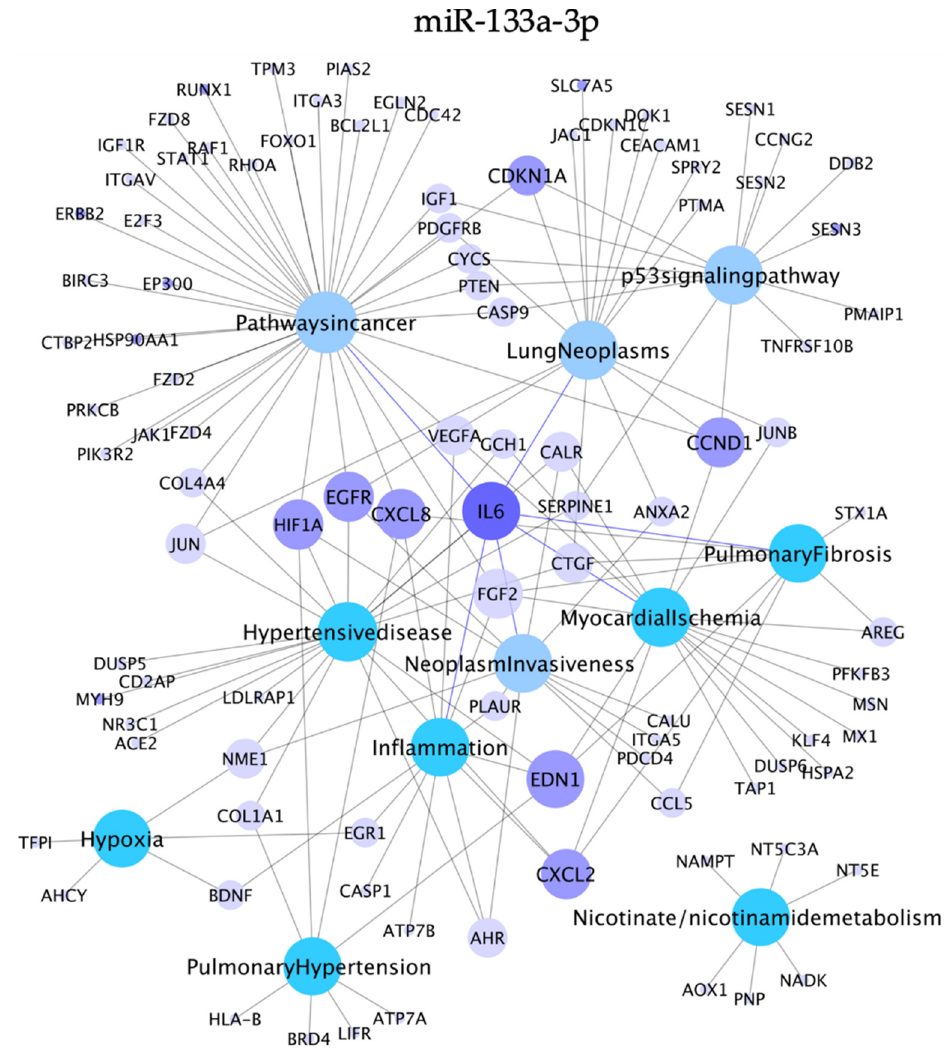
Figure 6. Network of the miR-133a-3p experimentally validated target genes and their enriched pathways. Figure shows the miR-133a-3p target genes that regulate selected pathways associated with cancer, inflammation, and smoking-associated diseases ( p < 0.01, KEGG database; and p < 0.005 DisGeNET database). The target genes are displayed as light purple circles, and enriched pathways are displayed as circles of various colors. The size corresponds to the number of interactions between genes and pathways. The genes shared by more than two miRNAs (indicated in Figure 5) are shown as dark purple circles. Cytoscape v3.1.0 was used for network visualization.